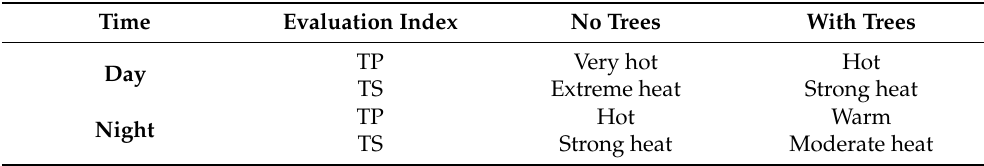
Table 6. Thermal perception (TP) and thermal stress (TS) with no trees and with